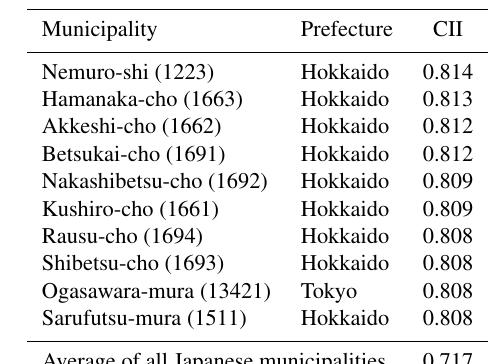
Table 2. A total of 10 municipalities with the highest average CII value over the study period (FY 2014–2016). The municipal number is shown in parenthesis.